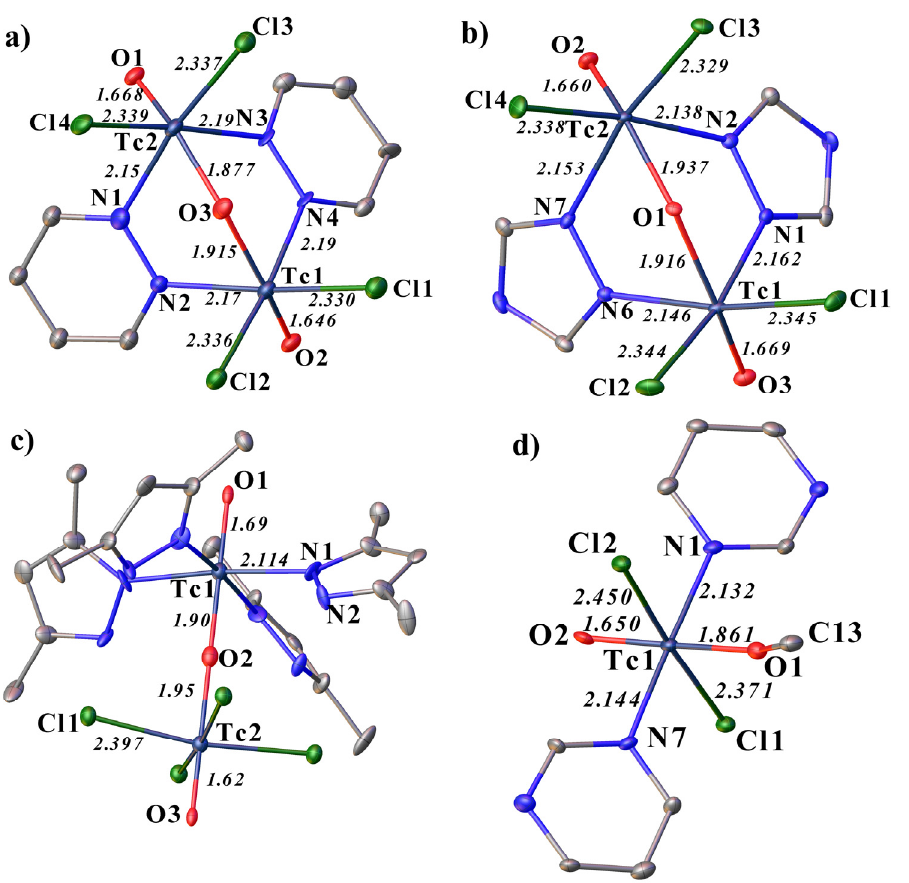
Figure 1. Molecular structure of 1 ( a ), 2 ( b ), 3 ( c ) and 4 ( d ) representing the coordination of the technetium atom with some bond lengths and labeling. Solvent molecules, counterions and H-atoms are omitted for clarity.